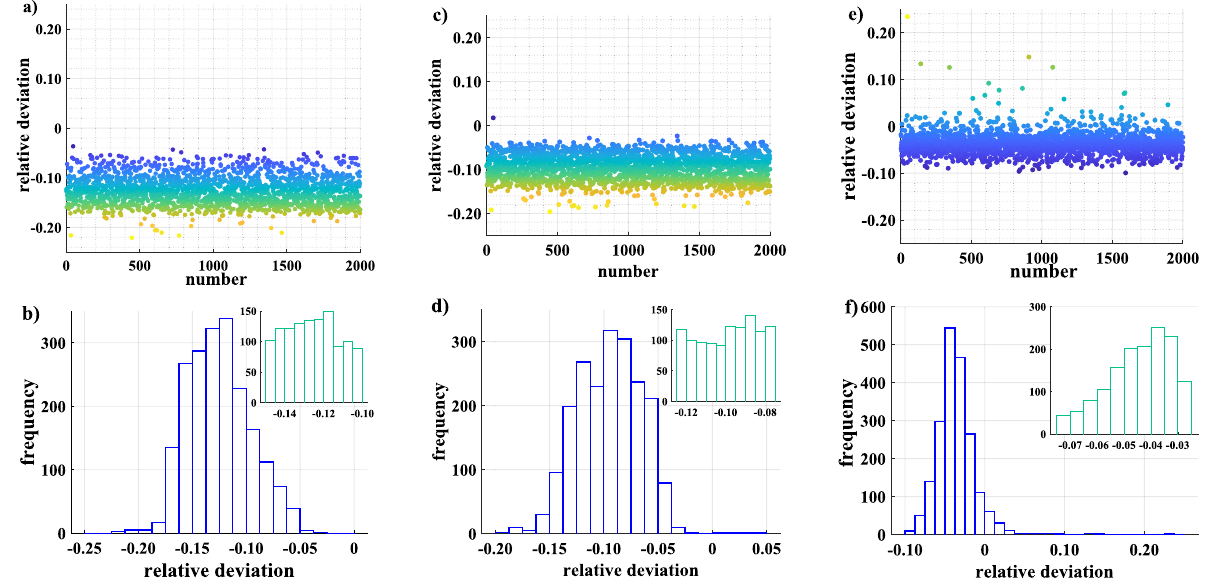
Figure 3. Performance comparison of neural networks with different hyperparameters. ( a ) The results of the 0.80 in predicting 2000 samples with excess noise 0.20 and ε neural network with the hyperparameters γ = = between 0.002 and 0.005 in the test set. The predicted key rates are strictly below the key rates obtained by the numerical method in Refs. 33,44 . ( b ) The histogram of the relative deviation distribution in ( a ). The absolute value of the relative deviations remains roughly in the region of 5–20%. ( c – f ) plot the corresponding results for the 0.90 and γ 0.80 , respectively. 0.20 , ε 0.80 , ε hyperparameters γ = = = =